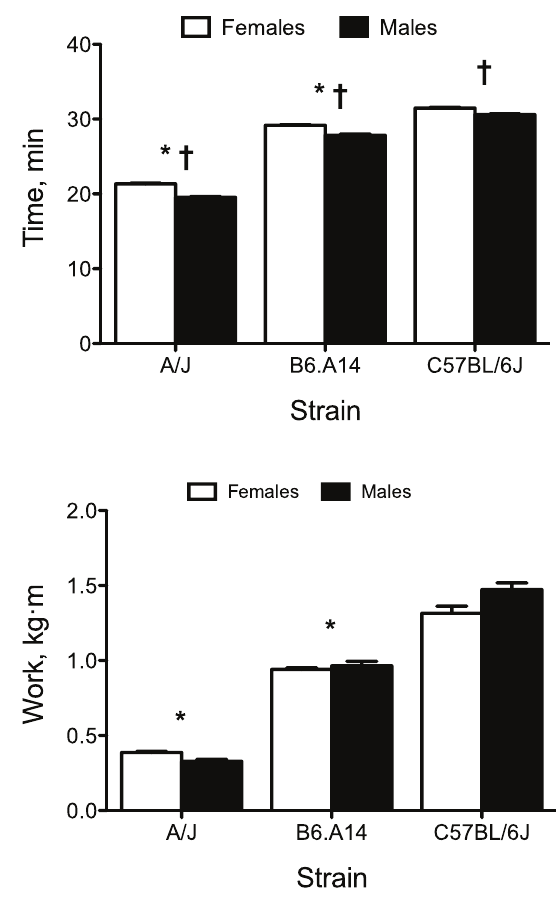
Figure 1. Strain- and sex-dependent differences in exercise capacity in male and female mice from A/J, C57BL/6J (B6), and B6.A14 chromosome substitution strains. Exercise capacity was assessed using a graded exercise test and expressed as ( A ) time in minutes or ( B ) work in kg·m. Values are expressed as mean ± SE. n = 6 mice per group. *P < 0.05 compared to B6; † P < 0.05 compared to